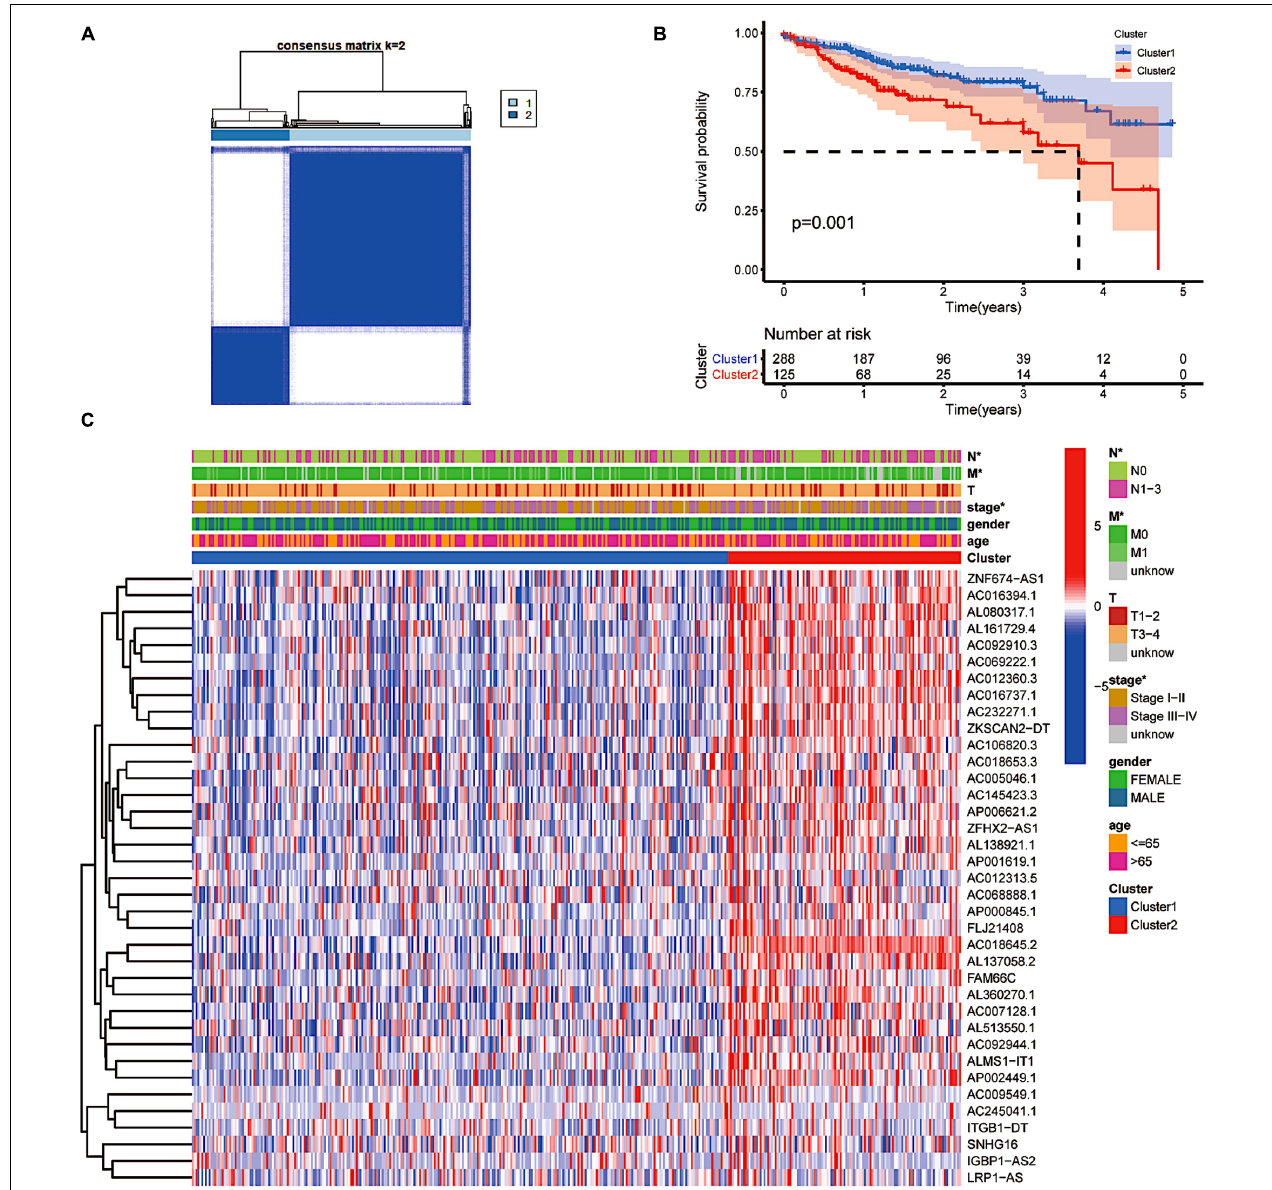
FIGURE 2 | The type of prognostic m6A-related lncRNAs that vary in prognosis and clinical characteristics. (A) Consensus matrix for optimal k = 2. (B) Kaplan–Meier overall survival (OS) curves for patients in distinct clusters ( p = 0.001). (C) Heat map of the associations between the expression levels of the 37 filtered m6A-related lncRNAs and clinicopathological features in the distinct clusters. * p < 0.05; ** p < 0.01; and *** p < 0.001.